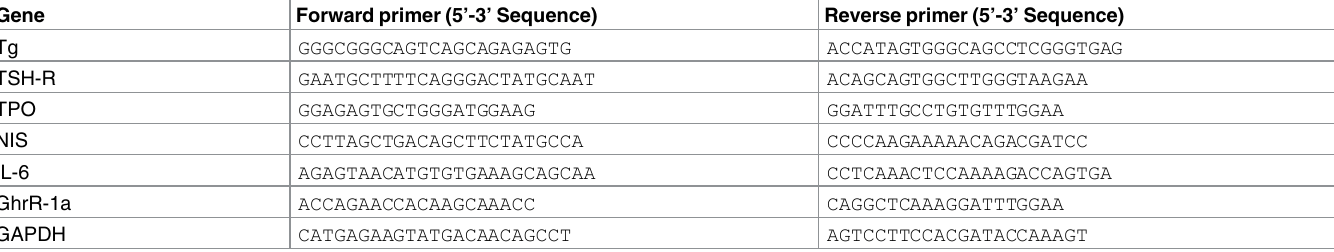
Table 1. Primer sequences for